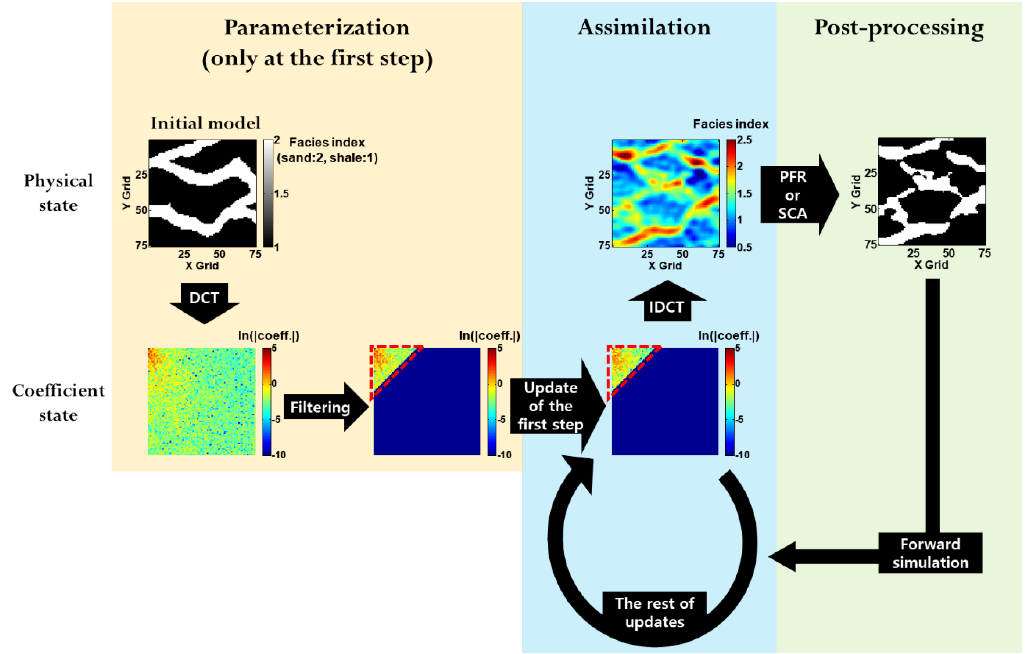
Figure 6. Example of overall update procedures of a channel reservoir using DCT.